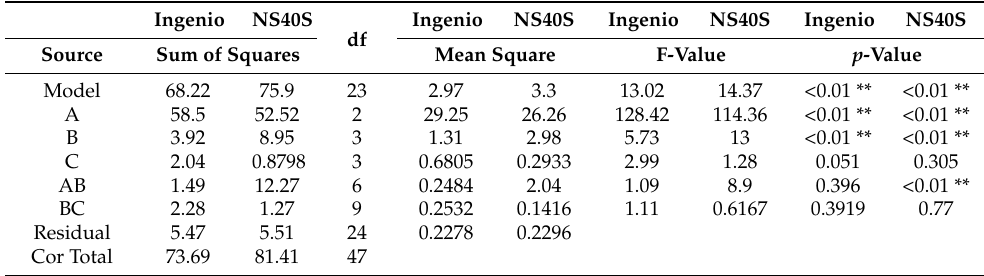
Table 11. ANOVA table for grain yield for the three-year time range (2018–2020).